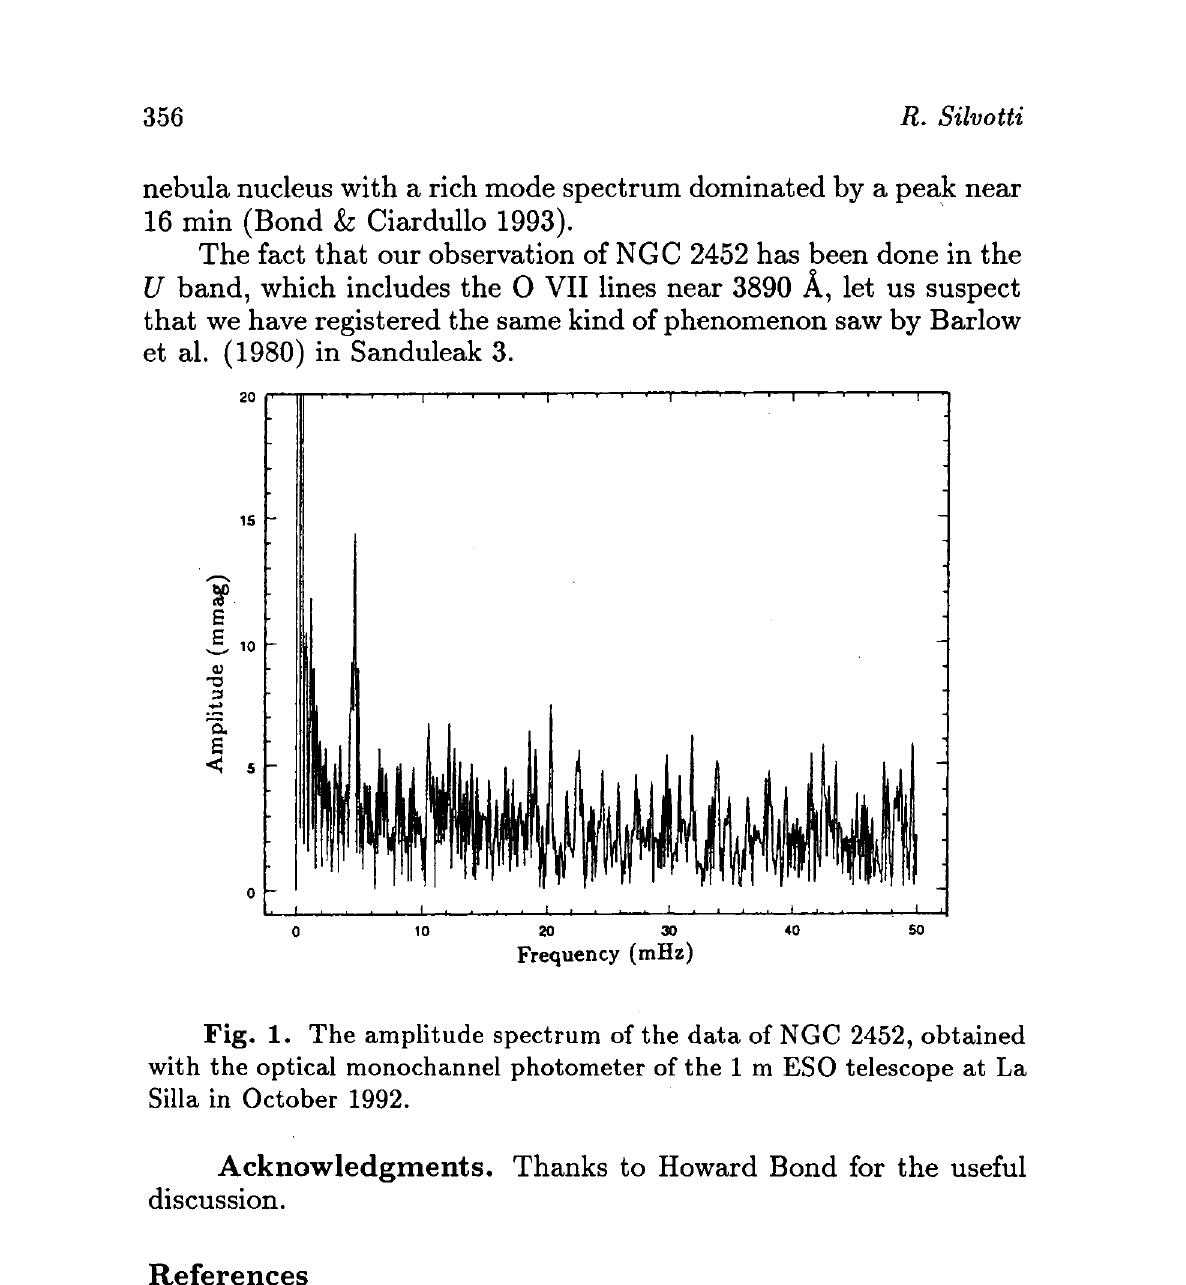
Fig. 1. The amplitude spectrum of the data of NGC 2452, obtained with the optical monochannel photometer of the 1 m ESO telescope at La Silla in October